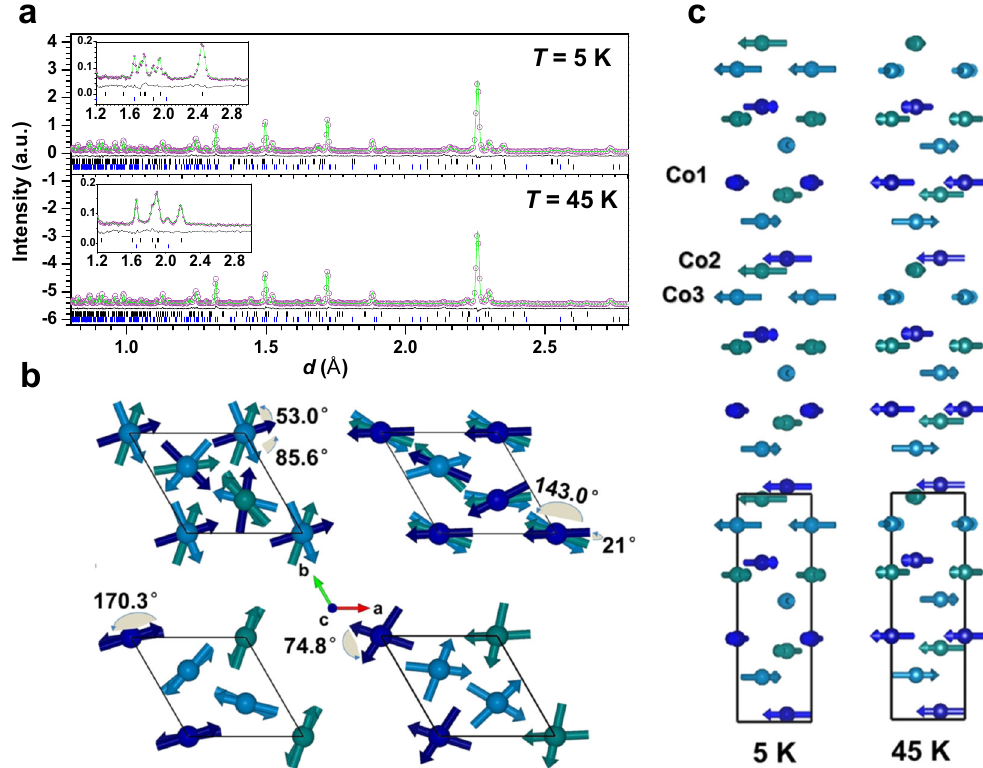
Fig. 4 Magnetic structure of HP-CTO determined from in situ variable temperature powder neutron diffraction measurements. a Experimental, calculated, and difference patterns from re fi nements of the NPD data at T = 5 and 45 K (high-resolution bank 2 (58°, ~1 – 9.6 Å)), insets show the re fi ned results of bank 3 (90°, ~0.7 – 6.6 Å) data. The blue and black bars mark the re fl ection positions for the nuclear re fl ections and magnetic satellites, respectively. b The arrangement of magnetic moments at T = 5 and 45 K. The unit cell for the nuclear structure is outlined. The arrangement of magnetic moments at T = 5 K (left panel of c ) and T = 45 K (right panel of c ) viewed along [001]. The blue spheres mark the Co1 atoms, green — Co2, light blue —